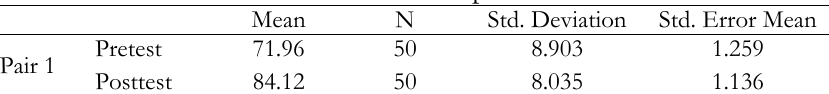
TABLE 3. Paired Samples Statistics